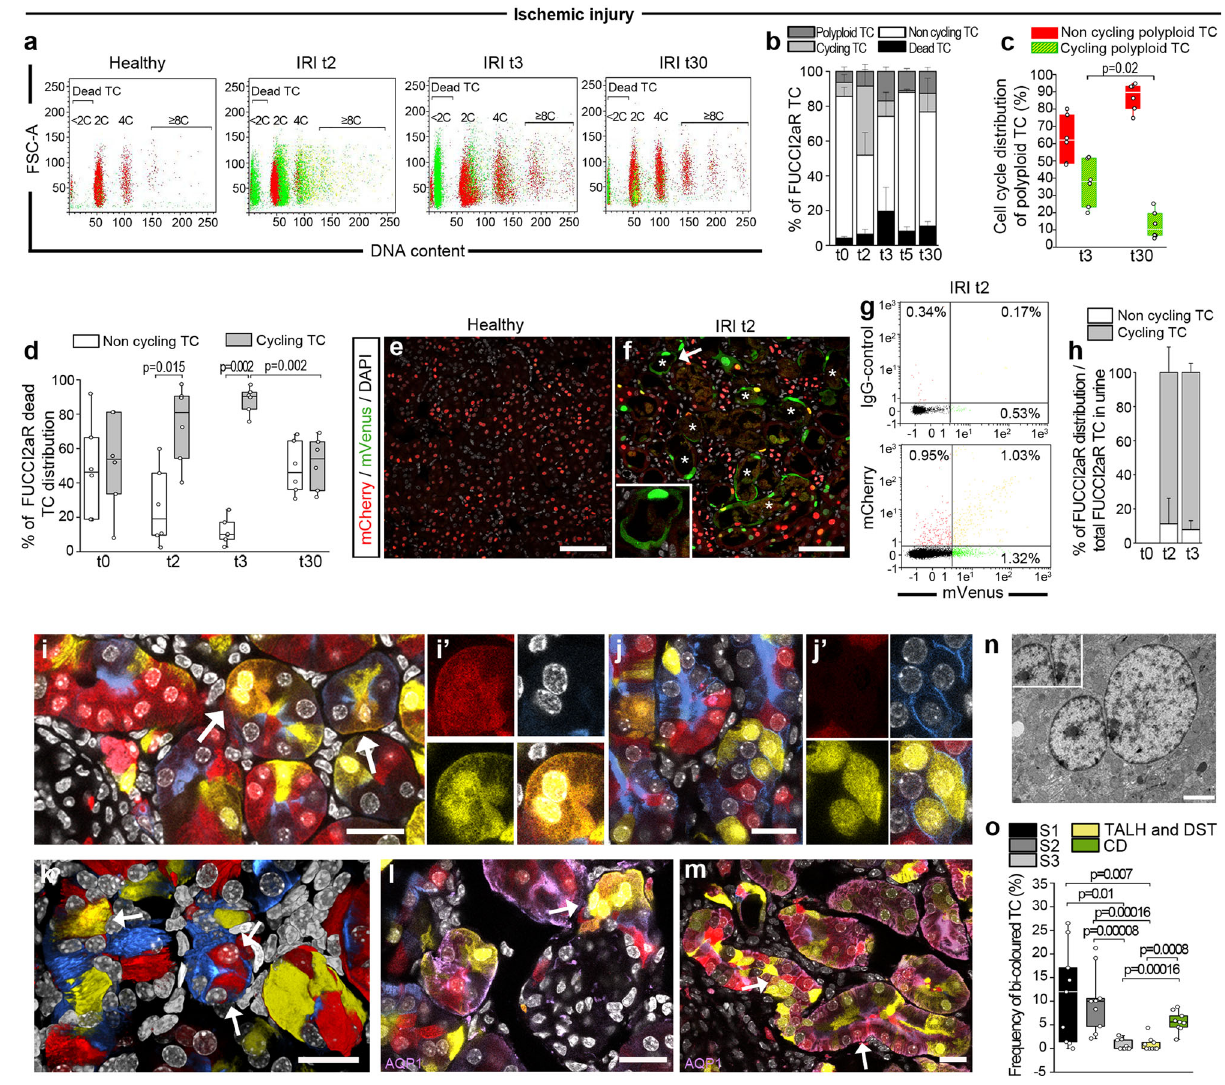
Fig. 1 | Themajority oftubular cells(TC) entering cell cyclebecomespolyploid ordies following AKI. a FACS plots of TC in Pax8/FUCCI2aR mice ( n =6) after IRI, showing dead (<2C), diploid (2C), tetraploid (4C) and octaploid or greater ( ≥ 8C) TC. Colours match those of the FUCCI2aR reporter. b FUCCI2aR TC distribution after IRI. Dead TC: t0 vs t3 p =0.015,t0 vs t30 p =0.008; t0 vs t5 p =0.015,cycling TC: t0 vs t2 p =0.002,t2 vs t3 p =0.002,t2 vs t5 p =0.002,t2 vs t30 p =0.015;PolyploidTC: t0 vs t3 p =0.002, t0 vs t5 p =0.026, t0 vs t30 p =0.008, t2 vs t3 p =0.002, t3 vs t5 p =0.004, t3 vs t30 p =0.026 ( n =6 each time point). c Distribution of polyploid TC across cell cycle after IRI ( n =6). d Distribution of FUCCI2aR dead TC analysed by FACS after IRI ( n =6). Representative pictures of e healthy and f two days after IRI Pax8/FUCCI2aR mice showing necrotic tubu les (*) with mVenus + TC. DAPI coun- terstains nuclei. Bars 75 µ m. The inlet is a higher magni fi cation of the tubule